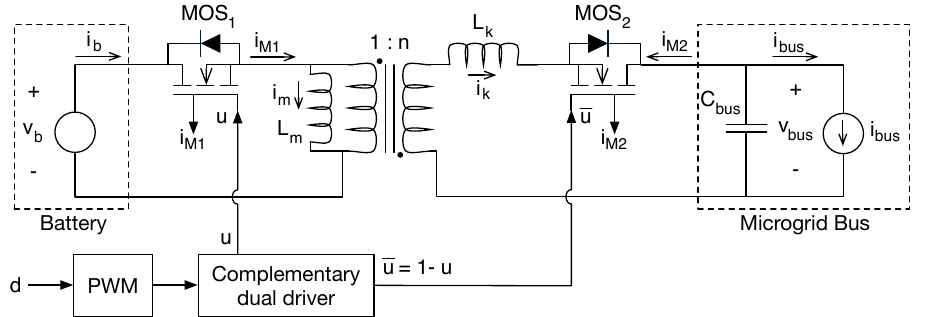
Figure 1. Flyback-based circuital interface for bidirectional power